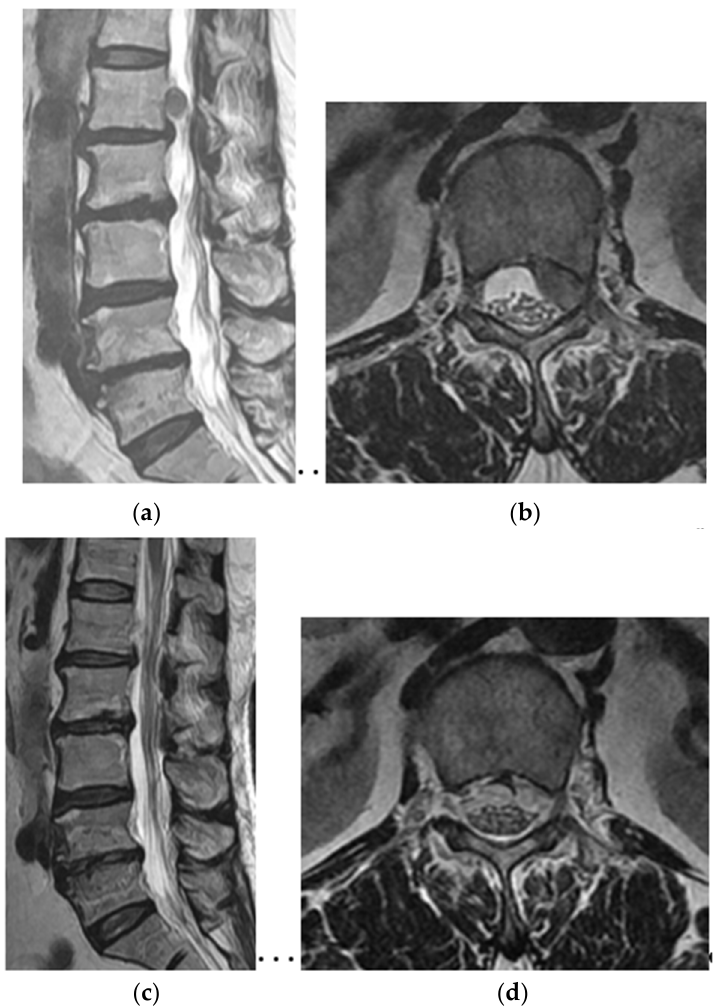
Figure 4. A 47-year-old man complained of radiating pain in the anterior thigh of the left leg. Preoperative MRI showed left-sided upward migrated disc herniation at L1–L2 ( a,b ). Ruptured disc fragments were removed using the fully endoscopic transforaminal approach (video S1). Although a small remnant disc particle was suspicious on postoperative MRI ( c,d ), radicular pain of left leg completely disappeared.